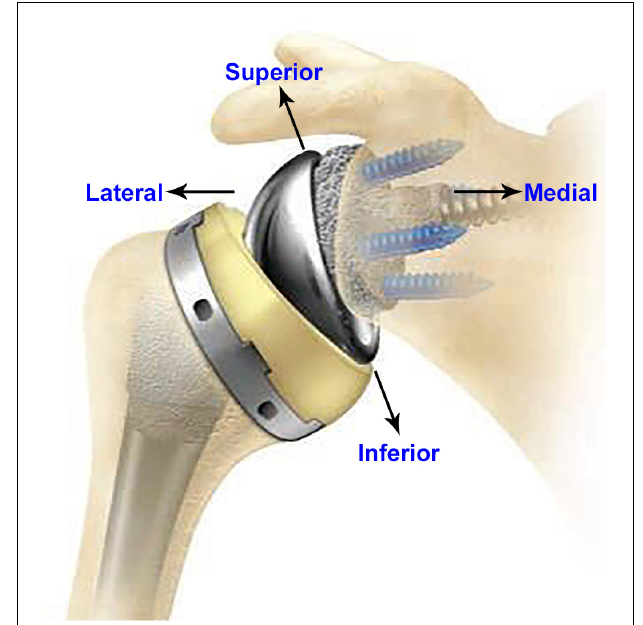
FIGURE 1 | A typical rTSA system (anterior–posterior